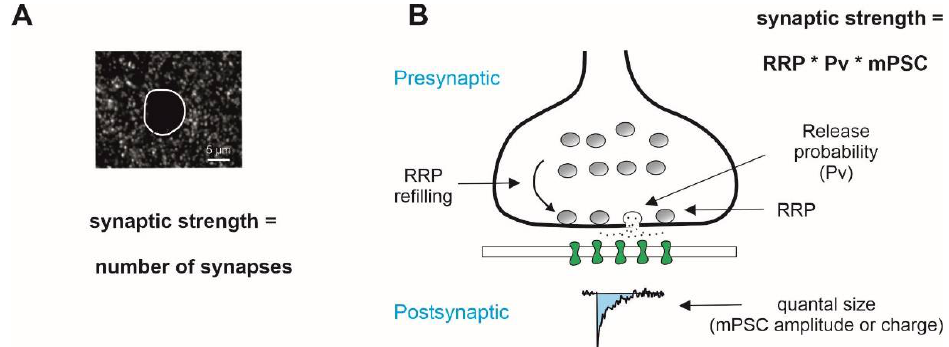
Figure 1. General mechanisms that determine the strength of synaptic transmission. ( A ) Number of synaptic contacts visualized immunohistochemically is frequently taken as an estimate of the strength of synaptic excitatory/inhibitory inputs. ( B ) Functional strength of synaptic drive in the frame of binomial model of synaptic transmission is determined presynaptically by RRP, the readily releasable pool of vesicles, and release probability, and postsynaptically by the quantal size, the amplitude of postsynaptic response to release of a single vesicle, and its kinetics (charge). Miniature postsynaptic currents (mPSCs), i.e., synaptic responses measured in the presence of tetrodotoxin, a blocker of voltage-gated Na+ channels, are often used as a quantal size estimate. Note that the RRP size is not a constant and depends of the rate of vesicle recycling, RRP refilling rate.